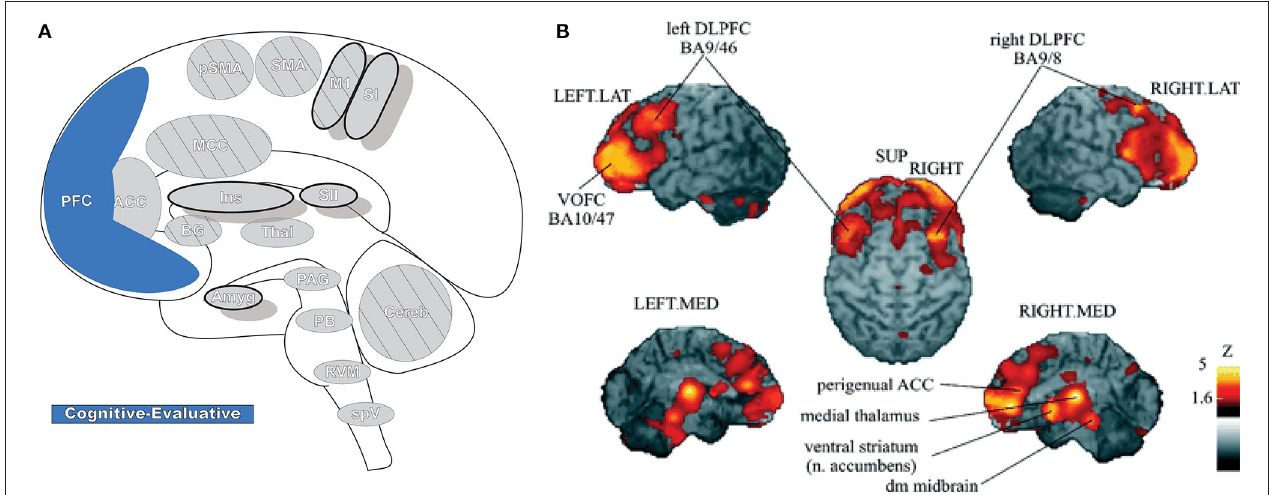
FIGURE 8 | Prefrontal cortex. (A) Brain areas active during pain: prefrontal cortex (PFC) highlighted. (B) Enhanced activation of ventral/orbitofrontal cortex (VOFC) and dorsolateral prefrontal cortex (DLPFC) during experimentally induced heat allodynia compared to equally intense heat pain stimuli. This difference demonstrates the nuanced response of the PFC in pain processing in different contexts. The basal ganglia were also found significantly more active in allodynia. Reprinted from J Lorenz, S Minoshima, KL Casey, Keeping pain out of mind: the role of the dorsolateral prefrontal cortex in pain modulation, Brain, Copyright (2003), Vol 126(5), p1079–91, by permission of Oxford University Press. DOI: https://doi.org/10.1093/brain/awg102. VOFC, ventral/orbitofrontal cortex; DLPFC, dorsolateral prefrontal cortex; LAT, lateral; MED, media; SUP, superior; dm,